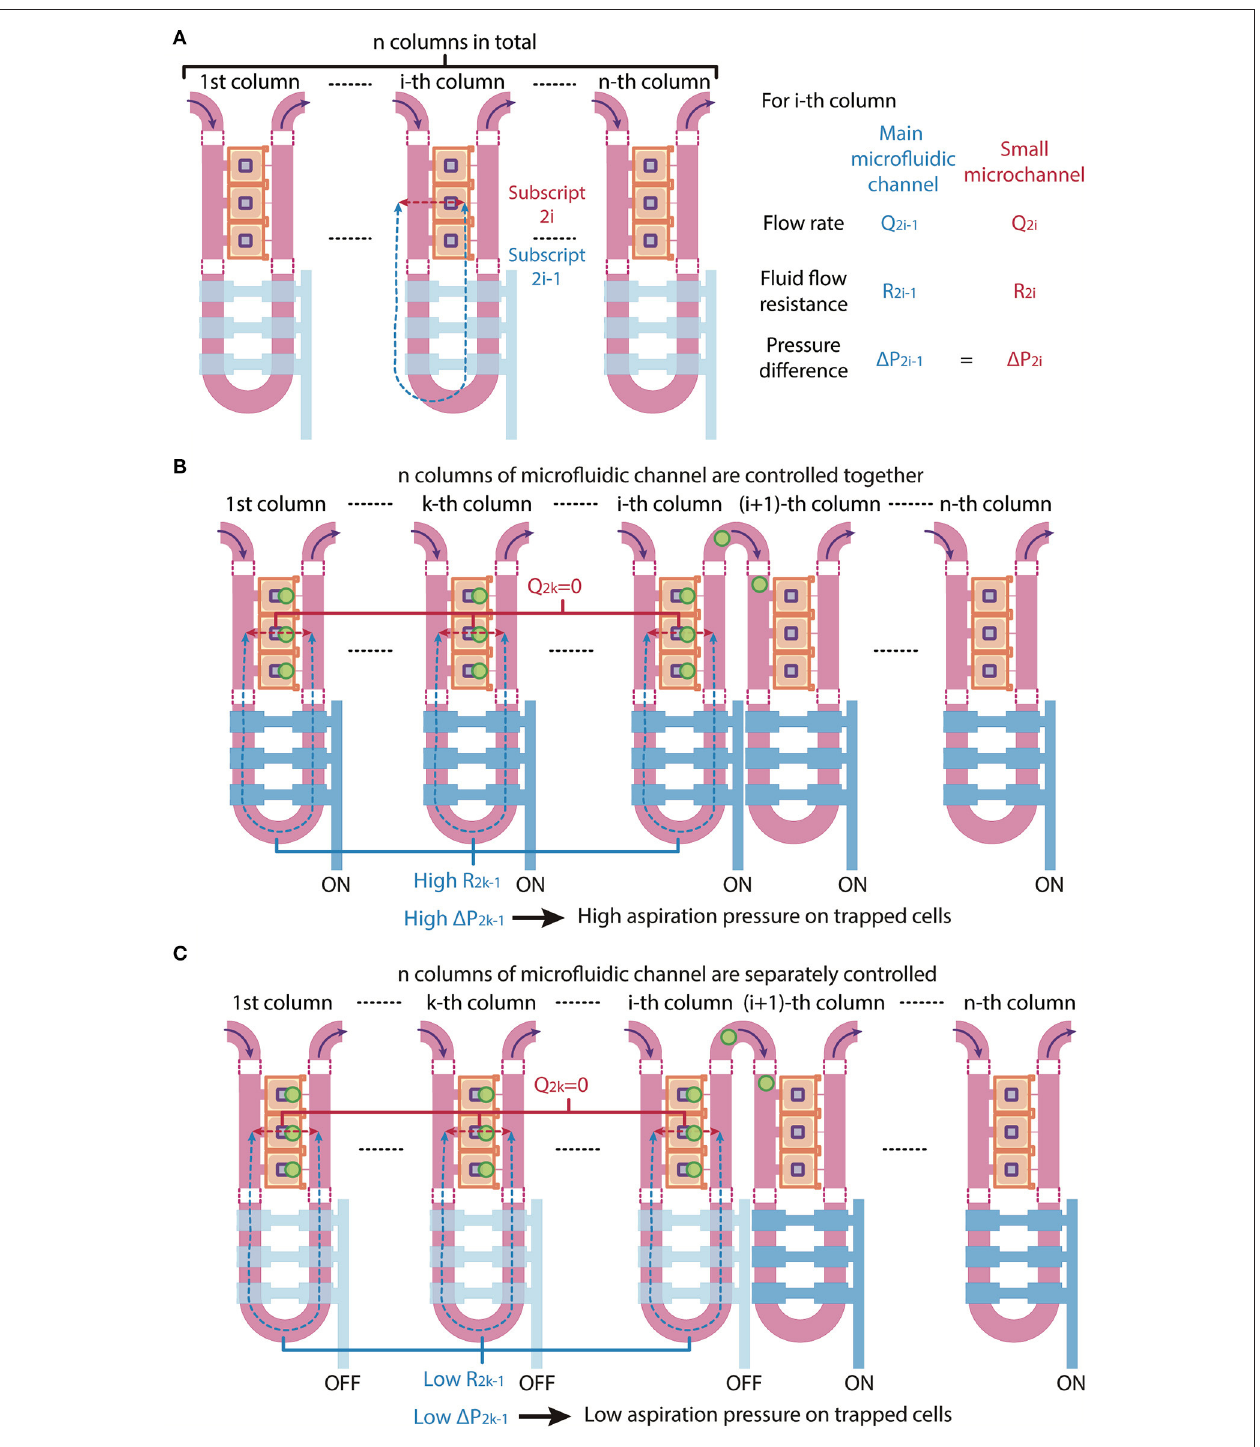
FIGURE 3 | Schematic of multi-column, separately-controlled cell trapping. (A) A schematic of a microfluidic channel with n individually controlled columns. Each column consists of two channels, so subscripts 2 i and 2 i -1 (with i = 1,2,3,…, n ) address individual channels. Pressures ( P ), flow rates ( Q ), and resistances ( R ) of the main microfluidic channel and the small microchannel were denoted in blue and red and are shown in the figure as blue and red dotted lines, respectively. (B,C) A schematic of the same microfluidic channel when the n columns of microfluidic channel are (B) controlled altogether (i.e., all values are ON ) or (C) separately controlled (i.e., valves 1 to i are OFF and valves i + 1 to n are ON ). The consequential changes in fluid flow resistance and pressure difference across cells are